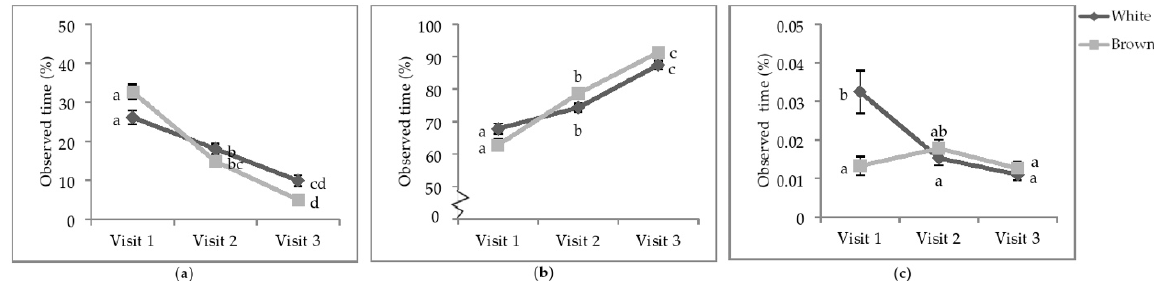
Figure 4. Least square means of the visit by colour interactions of state behaviours. Percentage of observed of time ( a ) sitting; ( b ) standing; ( c ) wing-assisted running. Visits one, two, and three were when the pullets were 25.9 ± 6.67; 68.0 ± 4.78 days of age; 112.1 ± 3.34 days of age. During visit one, the brooding compartments were closed, whereas during visits two and three, the brooding compartments were open into the litter areas. Error bars represent standard error. a–c Indicate significant differences between means ( p < 0.05).